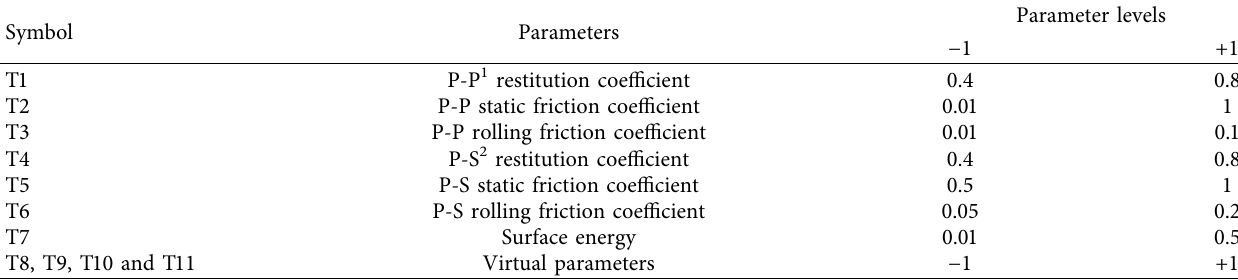
Table 1: Parameters of Plackett–Burman test.